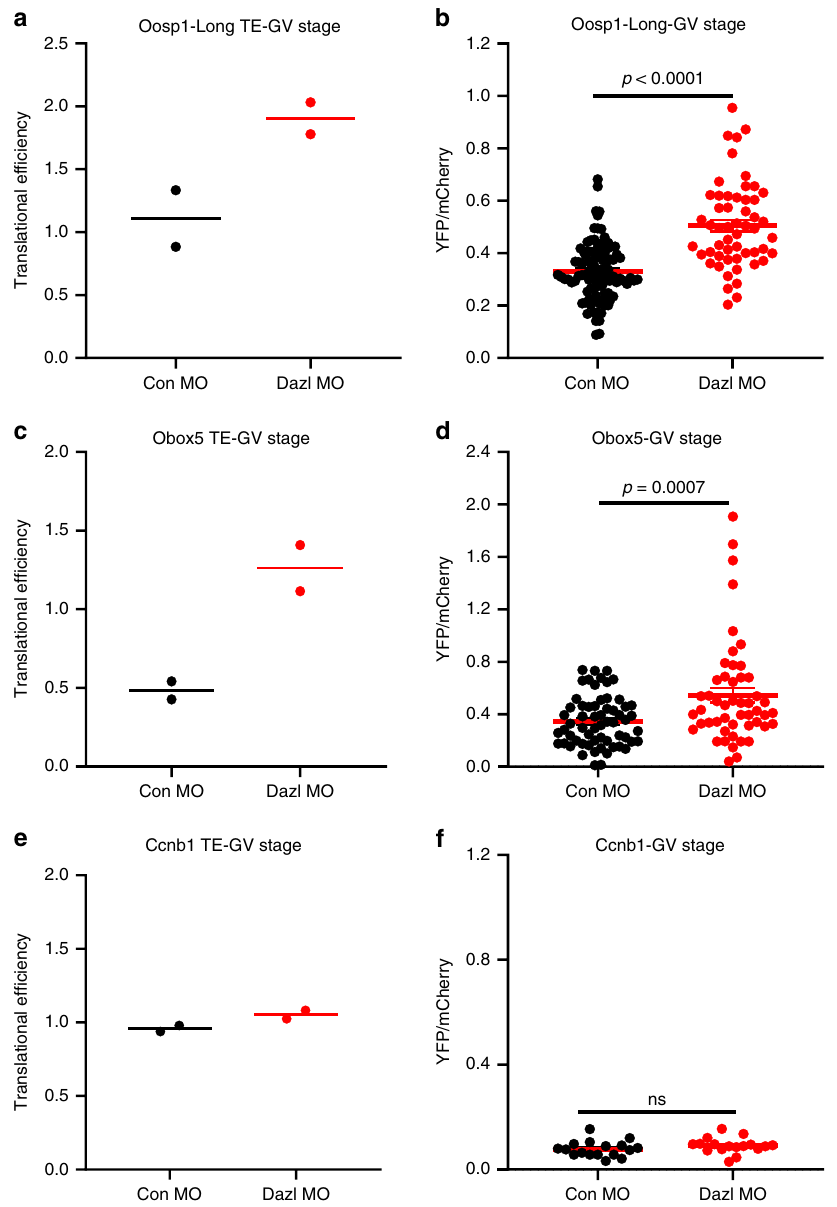
Fig. 7 DAZL depletion increases ribosome loading of Oosp1 and Obox5 endogenous transcripts and translation of the Oosp1 and Obox5 reporters in GV-arrested oocytes. a , c , e GV stage oocytes from RiboTag fl / fl :Zp3-Cre:WT or RiboTag fl / fl :Zp3-Cre:Dazl + / − mice were injected with CON-MO or DAZL- MO. Oocytes were pre-incubated overnight with 2 µ M milrinone. In all, 0 h (GV stage) data from RiboTag IP/ RNA-Seq were used to calculate the Translational Ef fi ciency (TE). TE is calculated as the ratio of the CPM for HA immunoprecipitated transcripts Oosp1 or Obox5 over the corresponding input at 0 h. The TEs are reported for Oosp1 ( a ) and Obox5 ( c ) or CcnB1 ( e ). Data are presented as mean of two biologically independent experiments for a , c , e . b , d , f GV stage oocytes were injected with mCherry -polyadenylated mRNA and YFP- 3 ′ UTR reporter for Oosp1 3 ′ UTR or Obox5 3 ′ UTR with either CON-MO or DAZL - MO. Oocytes were pre-incubated overnight to allow mCherry signal to plateau, then further incubated in cilostamide-containing medium. YFP signal were corrected by the level of coinjected mCherry signal. Reporters injected are: b Oosp1 (unpaired two tailed t -test, p < 0.0001), d Obox5 (unpaired two tailed t -test, p = 0.0007) and f CcnB1 (unpaired two tailed t -test, p = 0.2274). Data are presented as mean values ± SEM of rates for each individual oocytes from n = 3 independent biologically experiments for b , d , f 3 ′ UTR causes maximum increase in translation of the oligo- panel). Decreased translation of the reporter with time is detected adenylated reporter (Fig. 9d top panel). Whereas translation of in all other poly-adenylated constructs as it may become the double mutant does not signi fi cantly change if the reporter is deadenylated and partially repressed (Fig. 9d, bottom panel). arti fi cially poly-adenylated (Fig. 9d, bottom panel). The increased Since the effects in the double mutant are larger than in the single translation of the oligo-adenylated double mutant indicates that mutants, we argue for a synergism between the DAZL and CPE preventing the DAZL and CPEB1 binding causes adenylation of elements in exerting translational repression (Fig. 9d top panel). the reporter and de-repression. This effect is absent when the When the interaction between DAZL and CPEB1 is monitored reporter is already arti fi cially poly-adenylated (Fig. 9d, bottom during maturation, activated translation of Oosp1-short form